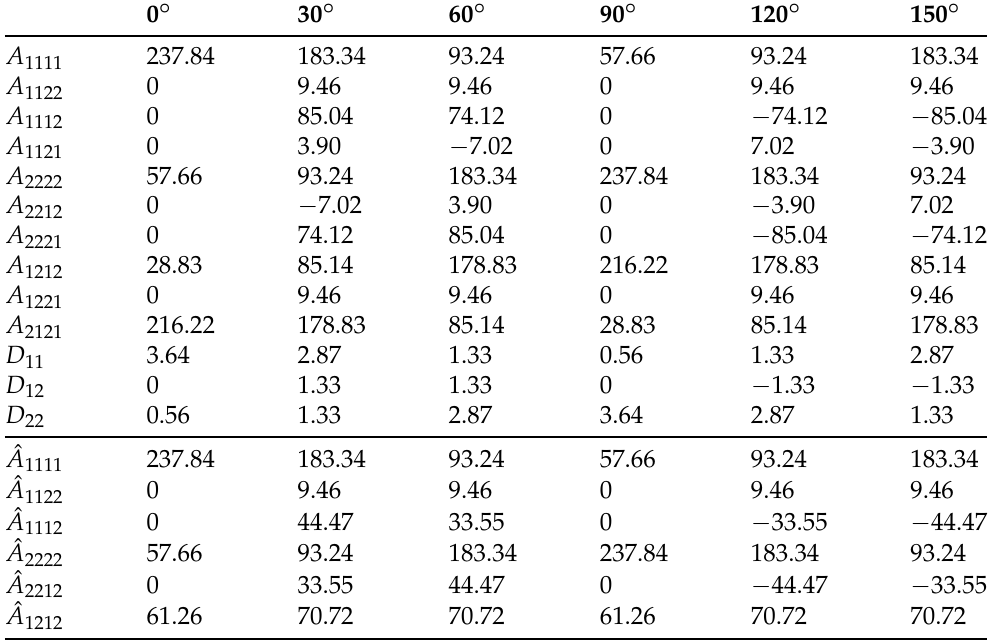
Table 2. Cosserat and Cauchy constitutive parameters for RVE with block parameter ρ = 3, A ijkl , ˆ A ijkl